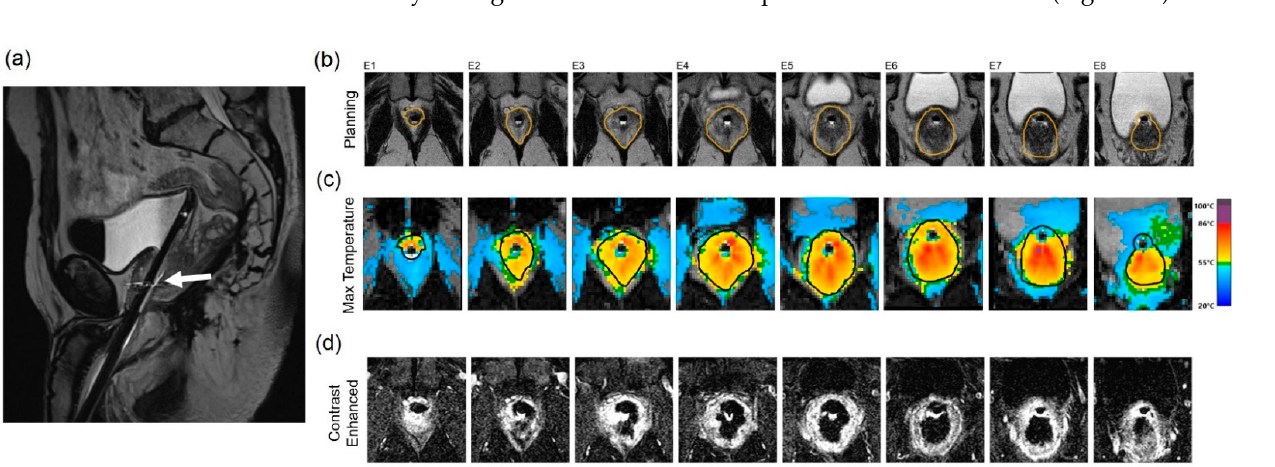
Figure 3. Treatment of a patient with localized, low-stage PCa with a TULSA-PRO device: ( a ) Sagittal T2-weighted MR image demonstrates the transurethral sonoablation device within the prostatic urethra and the tip within the bladder of a patient without a rectum (white arrow). ( b ) Axial T2-weighted MR planning images of the prostate at the level of 8 ultrasound transducers. The prostate boundary is contoured in orange. ( c ) MR thermometry images and color overlay demonstrate areas of heating. ( d ) Post-treatment imaging of the prostate acquired after gadolinium administration. Areas of bright signal demonstrate viable tissue, while dark areas indicate treated tissue.